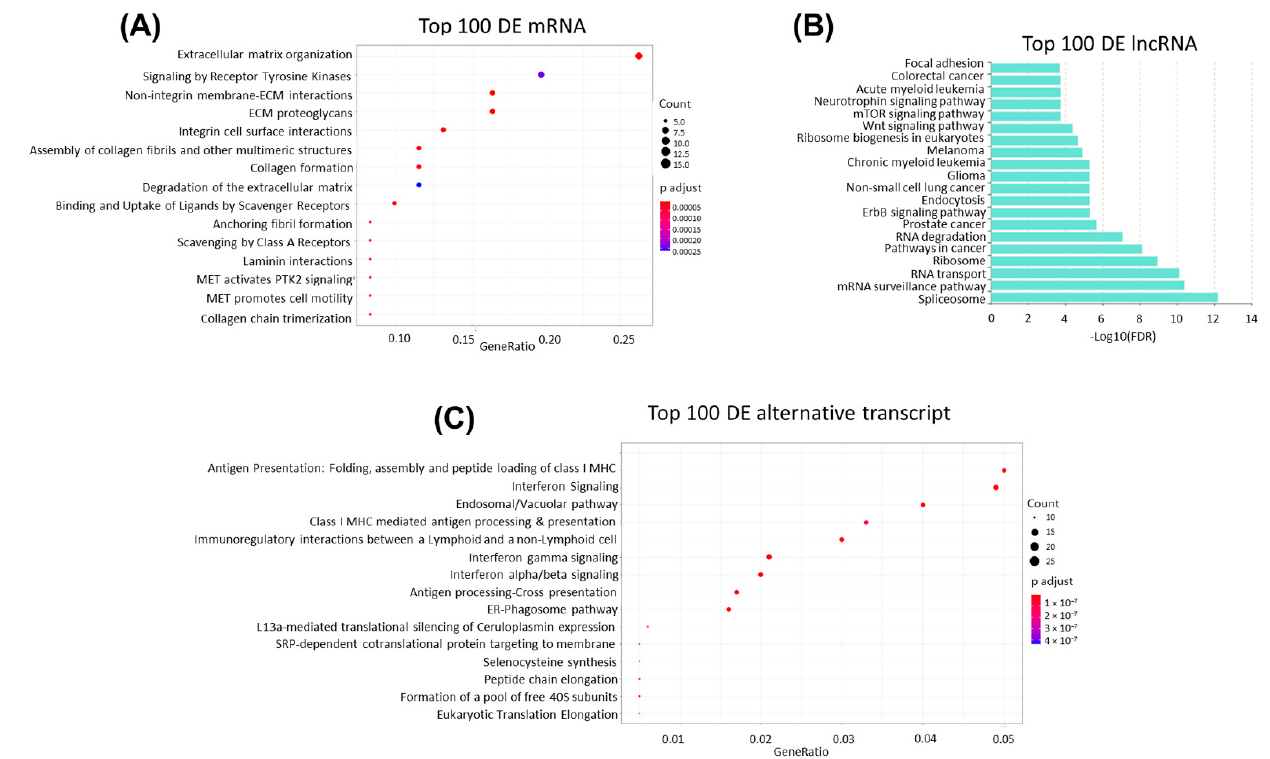
Figure 4. Biological processes or pathways associated with top 100 differentially expressed transcripts. Biological processes or pathways associated with statistically significant differentially expressed top 100 mRNAs ( A ), lncRNAs ( B ), and alternative transcripts ( C ) are shown with dot plots ( A , C ) or with a horizontal bar graph ( B ). GeneRatio and Count on plots represent the ratio of the genes that are annotated in a term and the number of genes that are a member to a given gene-set,